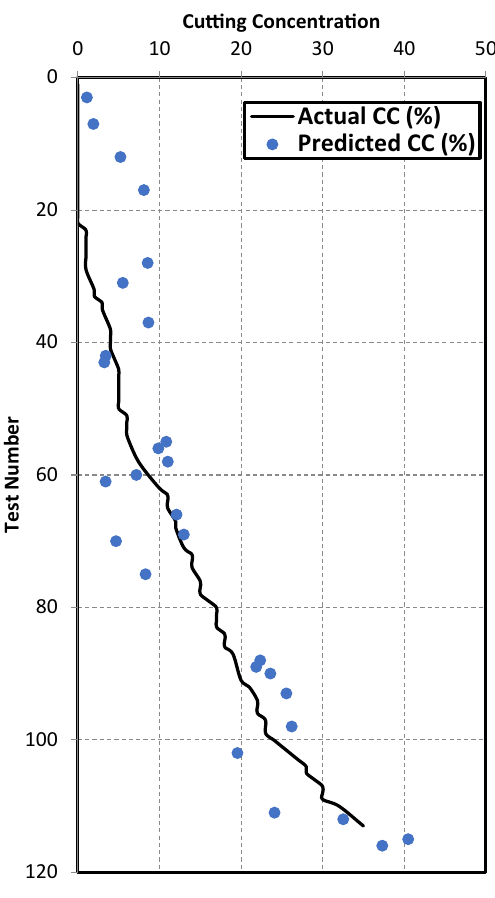
Fig. 13 Actual (experimental) and SVM-predicted cutting concentra- tion versus test number from training stage